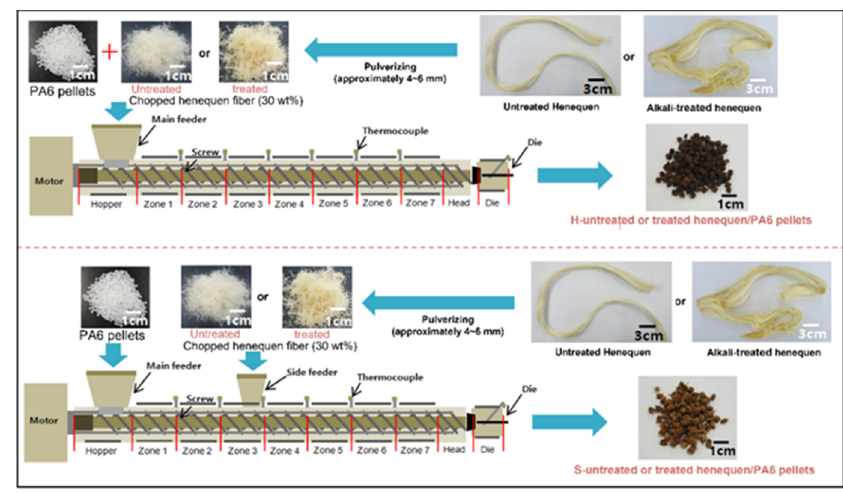
Figure 2. Illustration showing twin-screw extrusion process to prepare untreated and alkali-treated henequen fiber/PA6 pellets via hopper feeding and side feeding of henequen fiber, respectively.